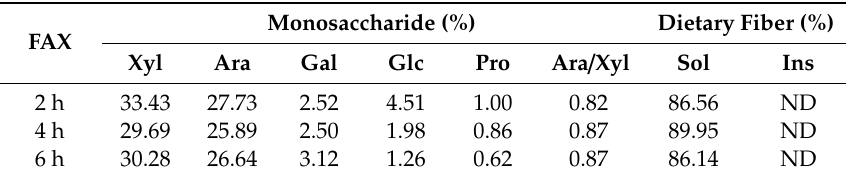
Table 5. Monosaccharide composition, protein content and the dietary fiber content of alkali-extracted feruloylated arabinoxylans from nixtamalized maize bran used in the present study. Monosaccharide (%) Dietary Fiber (%) FAX Xyl Ara Gal Glc